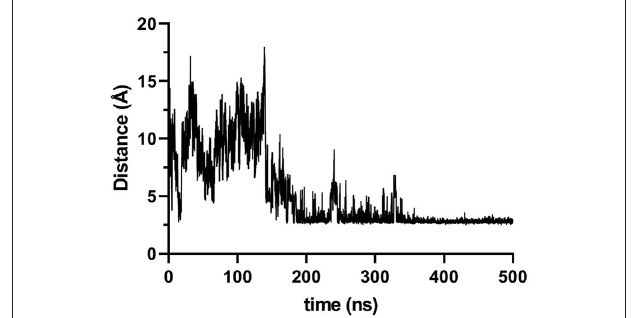
FIGURE 3 | Distance, in Ångström, between Arg181 and Asp29 during simulation time of MICA. Distance was measured considering N ε of Arg181 and oxygen atoms of Asp29. The figure reveals that around 200 ns this hydrogen bond remains stable for the rest of the simulation.